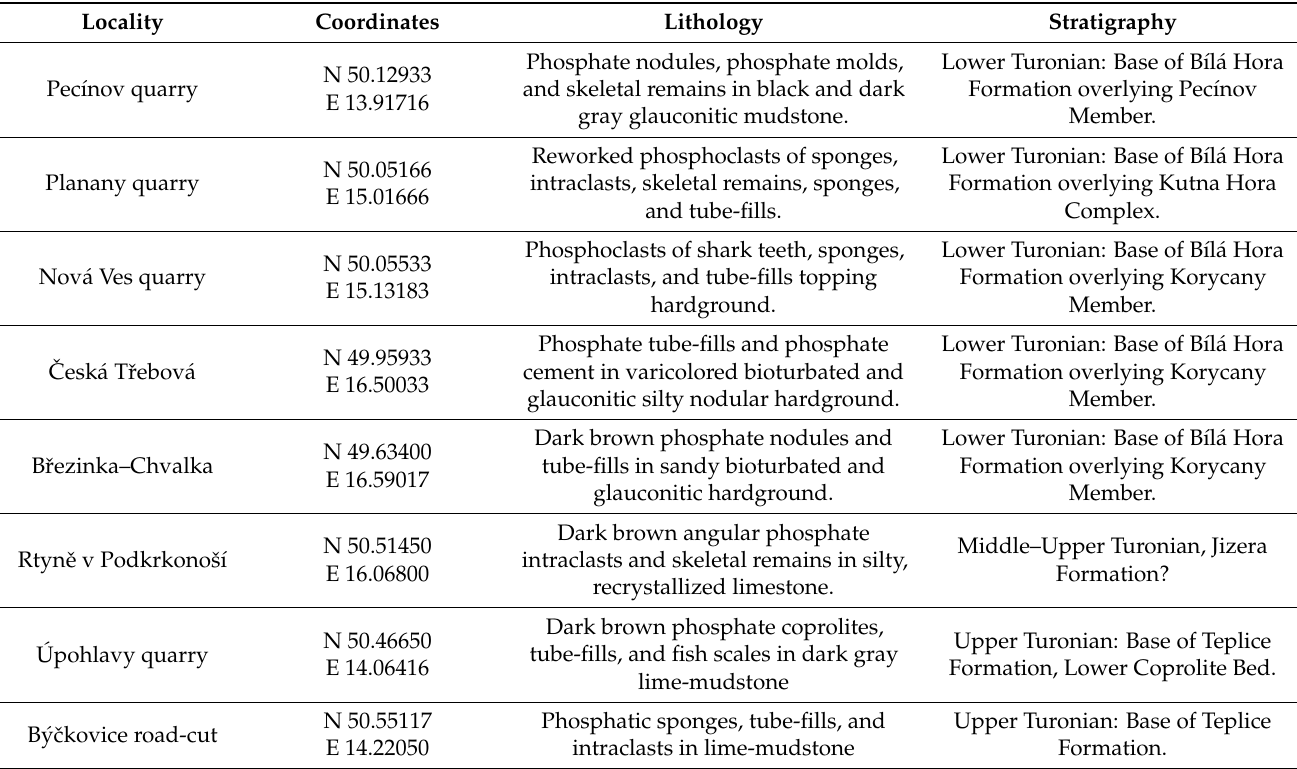
Table 1. Turonian phosphate occurrences reported in the present